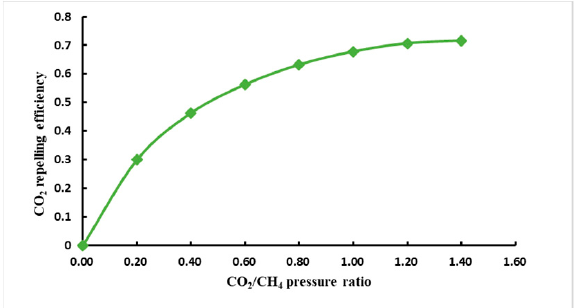
Figure 10. Carbon dioxide repulsion efficiency.